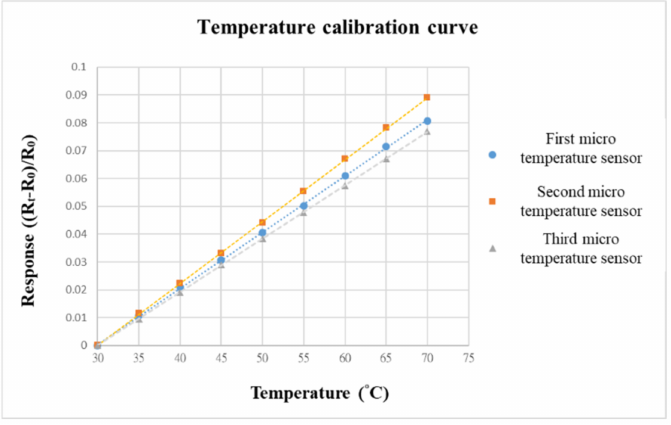
Figure 8. Temperature-calibration